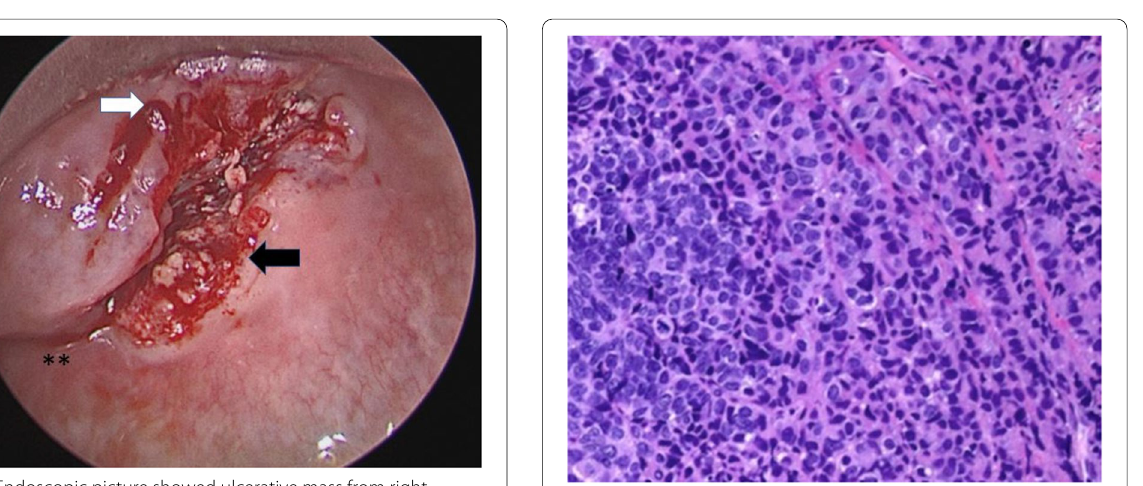
Fig. 3 HPE is similar to counterpart of pulmonary small cell carcinoma. There was the presence of loose aggregates of uniform small cells with indistinct cell borders, scant cytoplasm, hyperchromatic nuclei with fine granular chromatin, and nuclear molding